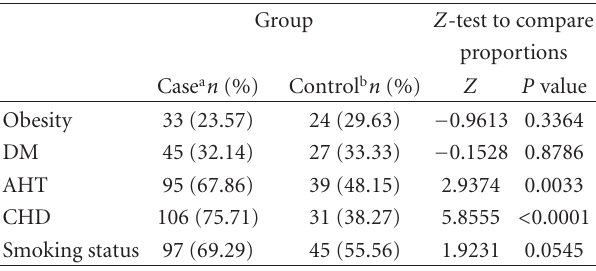
Table 1: Associated diseases: comparison between case and control